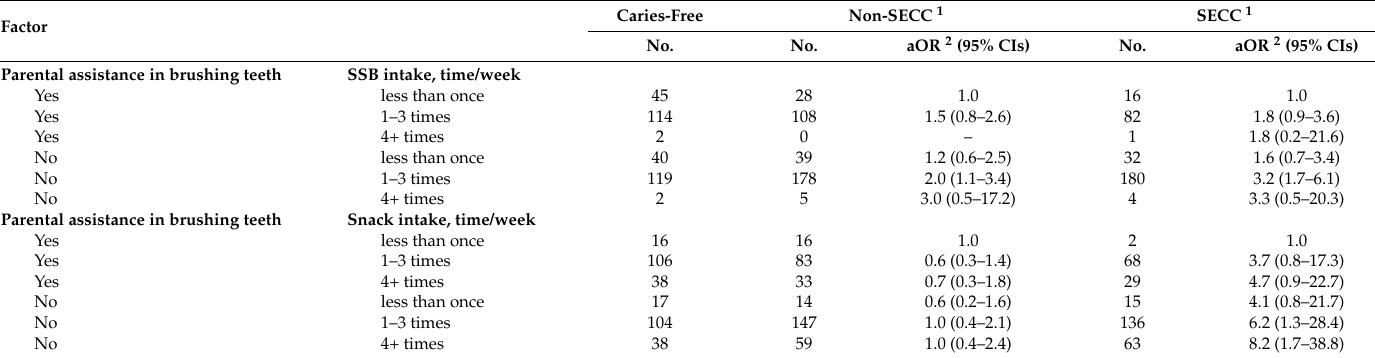
Table 6. Combined effects of dental caries preventive behaviors and sugar-sweetened beverage or snack intake on the dental caries status in immigrant